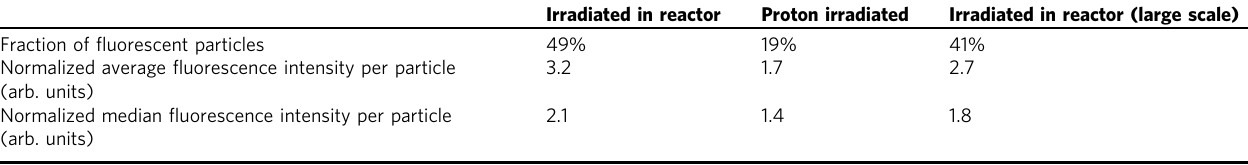
Irradiated in reactor Proton irradiated Irradiated in reactor (large scale)